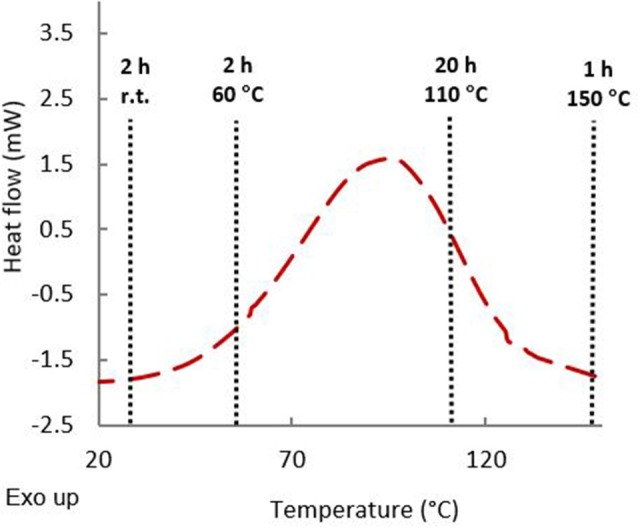
DSC analysis of an equimolar mixture of GDF10EPO and curing agent (IPDA).